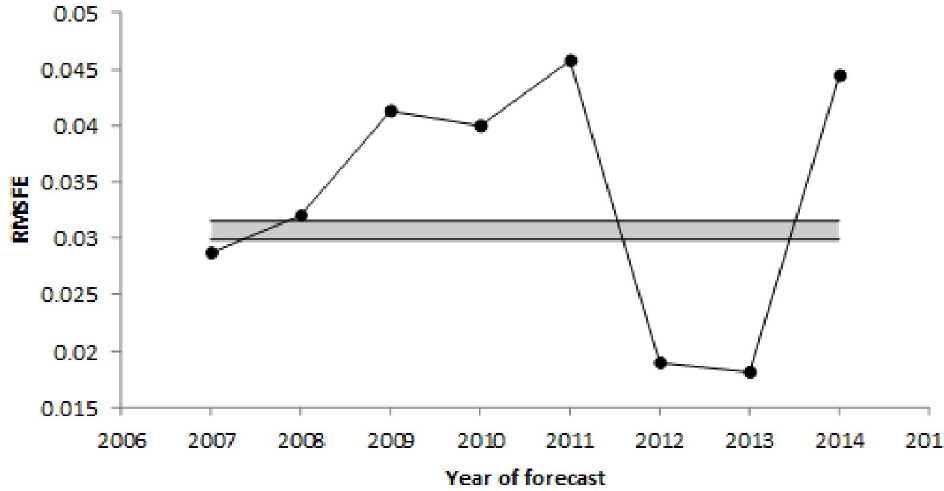
Fig 2. One-step-ahead forecast RMSE, 2007 to 2014. The gray bar represents the range of regression standard errors for the estimation samples for years 2016–2014. RMSFE: Root Mean Square Forecast Error.